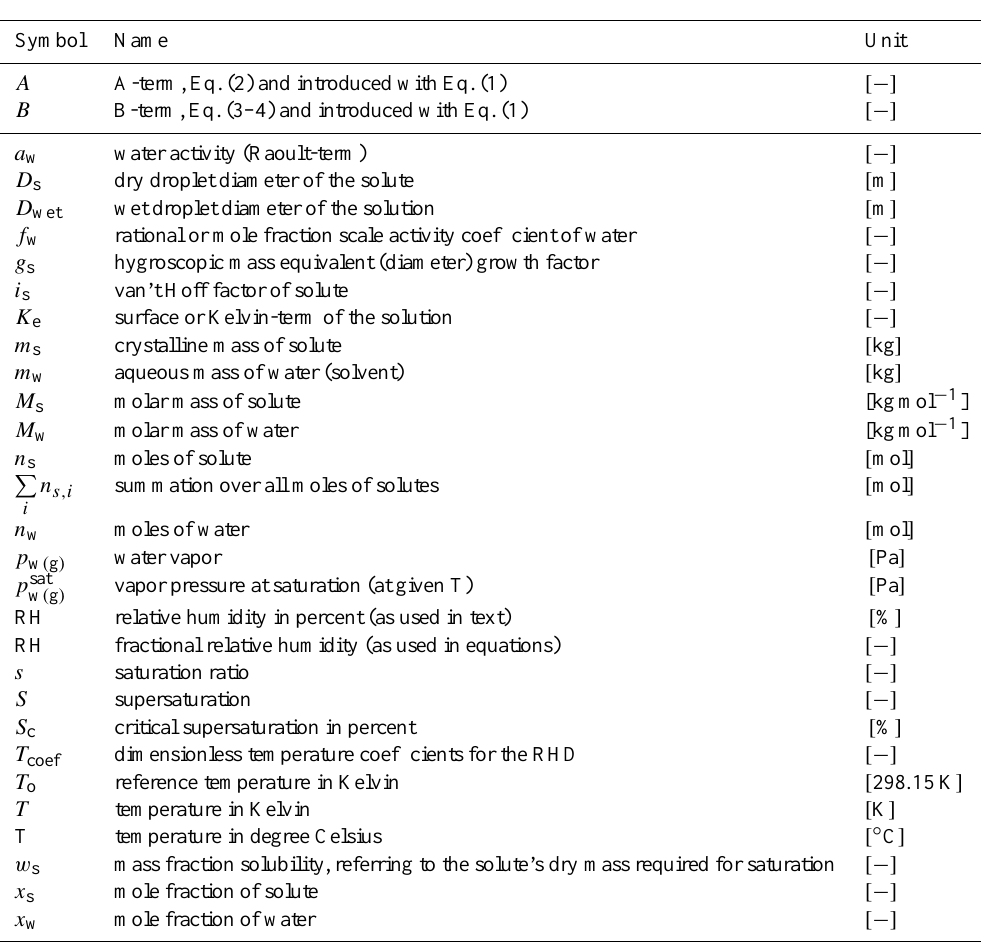
Table A2. List of